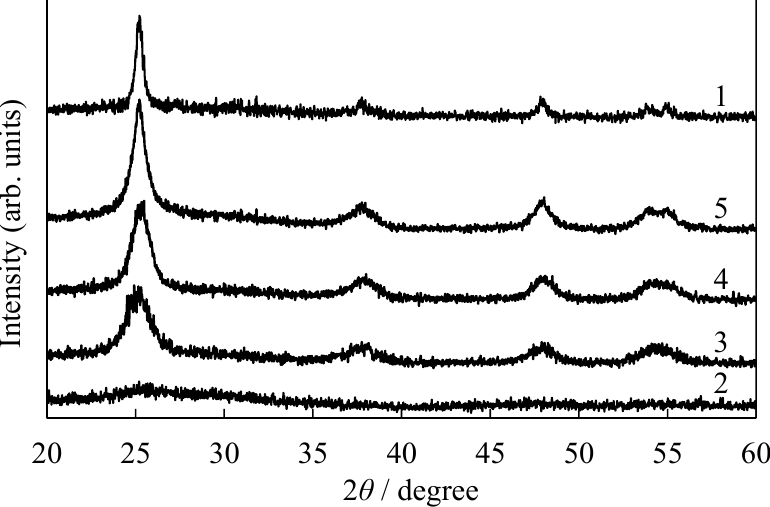
Figure 2. XRD patterns of (1) Sample T; (2) Sample S0; (3) Sample S300; (4) Sample S400 and (5) Sample